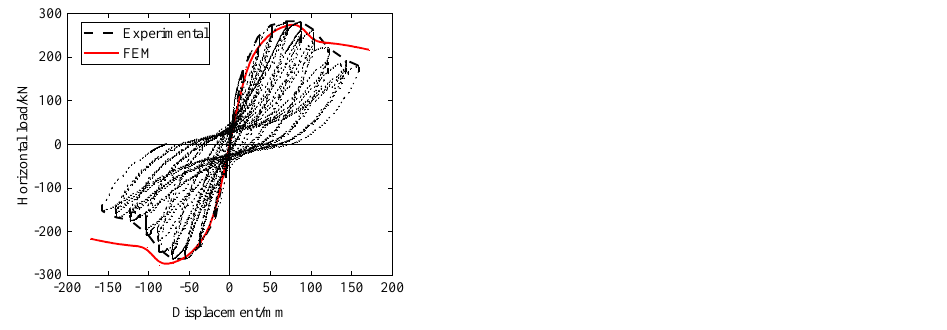
Figure 7. Failure pattern of specimen in FEM.